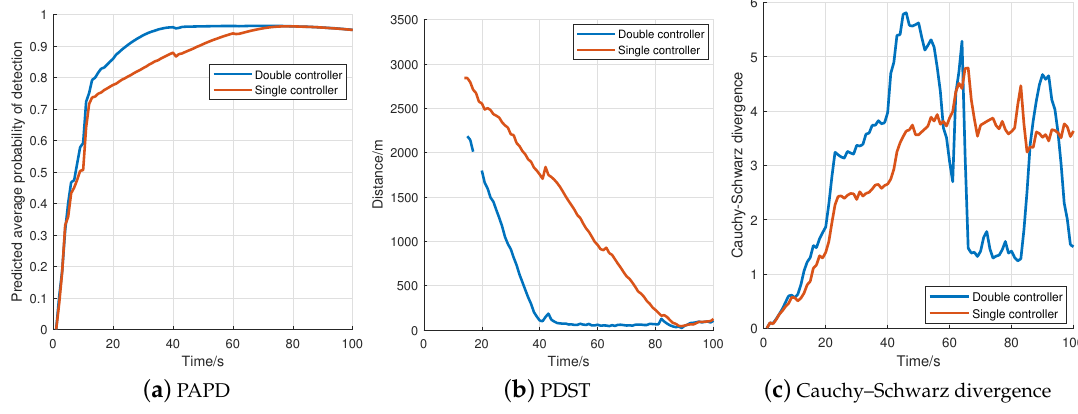
Figure 9. The average evaluation values for Controller 1 (100 Monte Carlo trials).